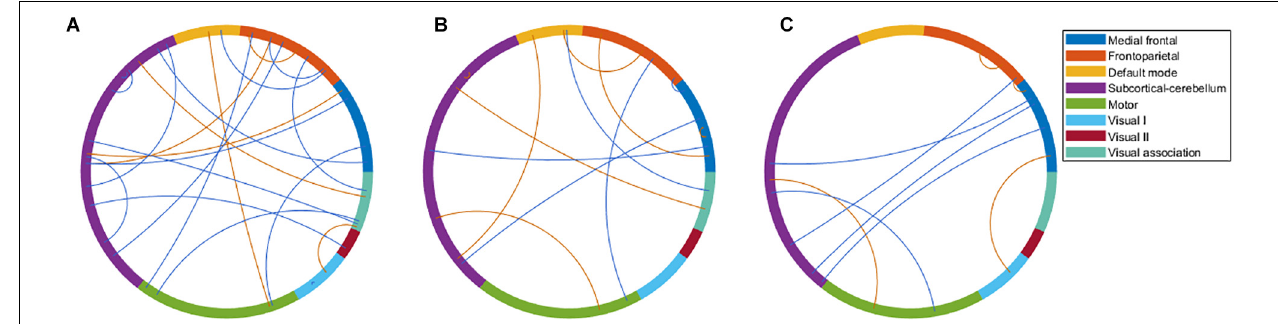
FIGURE 2 | The major features after the 10 times process of minimum redundancy/maximum relevance selection during the outer loop of the nested cross-validation illustrated using the eight networks of Shen’s 268-region parcellation. (A) The major features that were selected nine or 10 times during the nested cross-validation of the bipolar disorder and healthy control groups. (B) The major features that were selected 10 times during the nested cross-validation of the bipolar I disorder and healthy controls groups. (C) The major features that were selected 10 times during the nested cross-validation of the bipolar II disorder and healthy control groups. (B,C) were selected 10 times because of the very large number of features selected when nine or 10 times were used. To make the illustration more readable, only the features selected 10 times are shown. Red line represents the connectivity of patients being higher than healthy controls, and blue line represents the connectivity of patients being lower than healthy